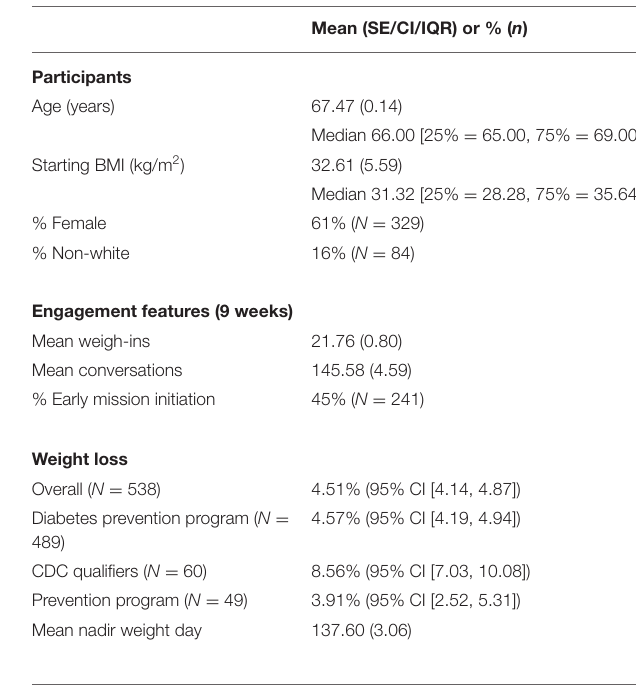
TABLE 1 | Participants, engagement, and outcome